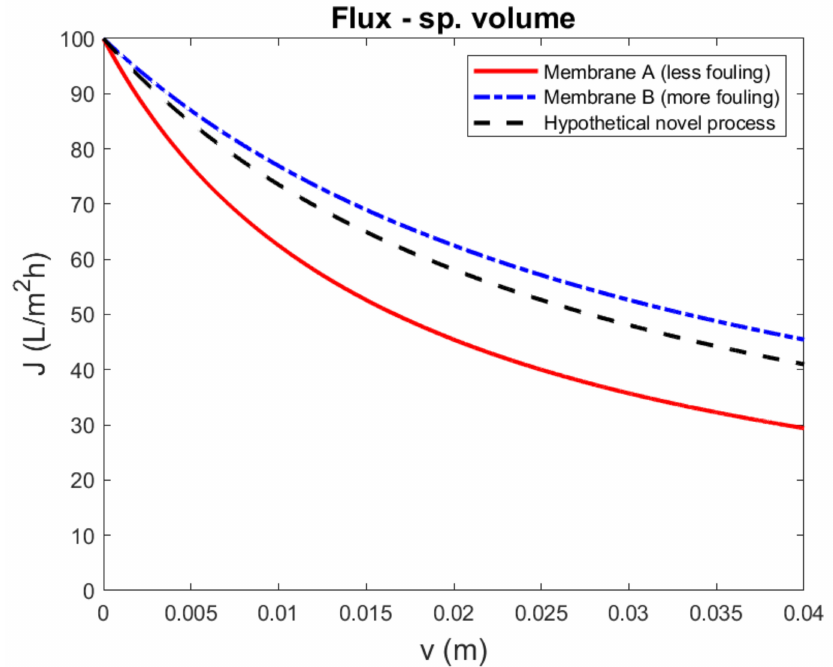
Figure 3. Simulated flux-decline curves to compare a hypothetical novel membrane process to ultrafiltration. The example was constructed such that membrane A was superior to membrane B, due to both a lower membrane resistance ( R MA = 0.5 × 10 12 m − 1 vs. R MB = 2.0 × 10 12 m − 1 ) and a lower fouling rate ( α A = 3.0 × 10 13 m − 2 vs. α B = 6.0 × 10 13 m − 2 ). The transmembrane pressure was chosen to have identical initial flux (TMP A = 0.14 bar, TMP B = 0.56 bar). The fouling mechanism of the novel membrane was assumed to be unknown, but constructed to lie between the curves of membrane A and B. If the novel membrane process was compared with a more-fouling and less-permeable reference membrane, it appeared that the fouling rate of the novel process was worse; conversely, if the less-fouling, more-permeable reference membrane was used, it appeared that the novel process fouled